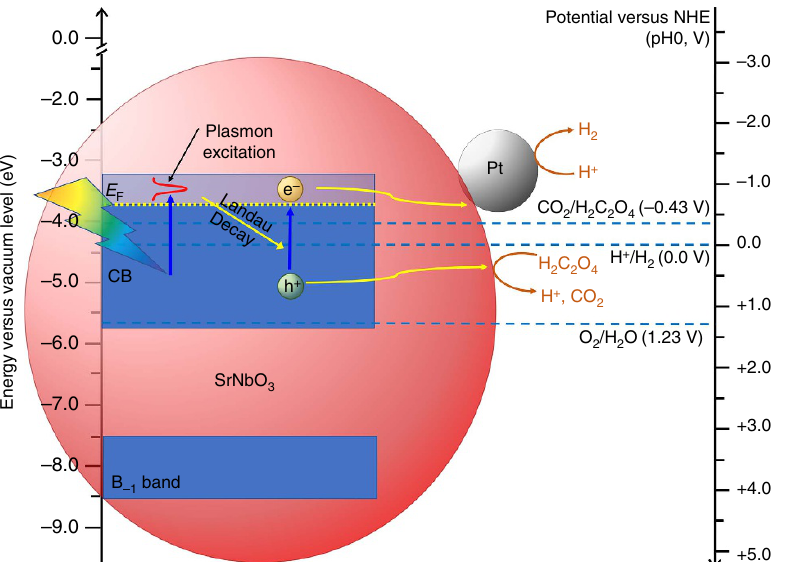
Figure 5 | Schematic of the photocatalytic hydrogen evolution reaction on Pt-loaded SrNbO 3 . CB, conduction band; B (cid:2) 1 band, the highest fully occupied band below CB. The Fermi level (from UPS measurement) and the widths of CB and B (cid:2) 1 band shown (from DFT calculations) in this figure are for illustration